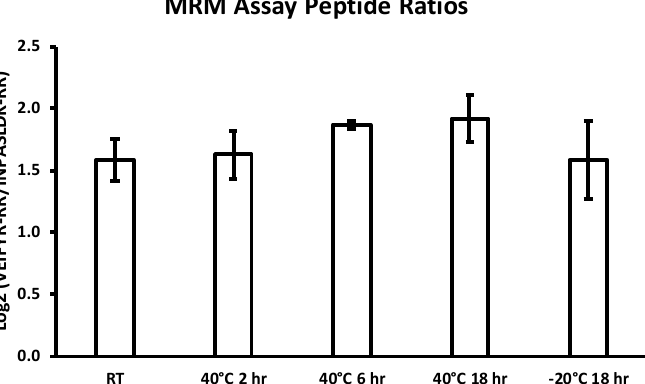
Figure 4. Peptide ratios measured by the Multiple Reaction Monitoring (MRM) assay for specimens applied to the BCD, dried and subjected to incubation at extreme environmental temperatures that may be encountered during transport. The error bars represent one standard deviation from the mean.